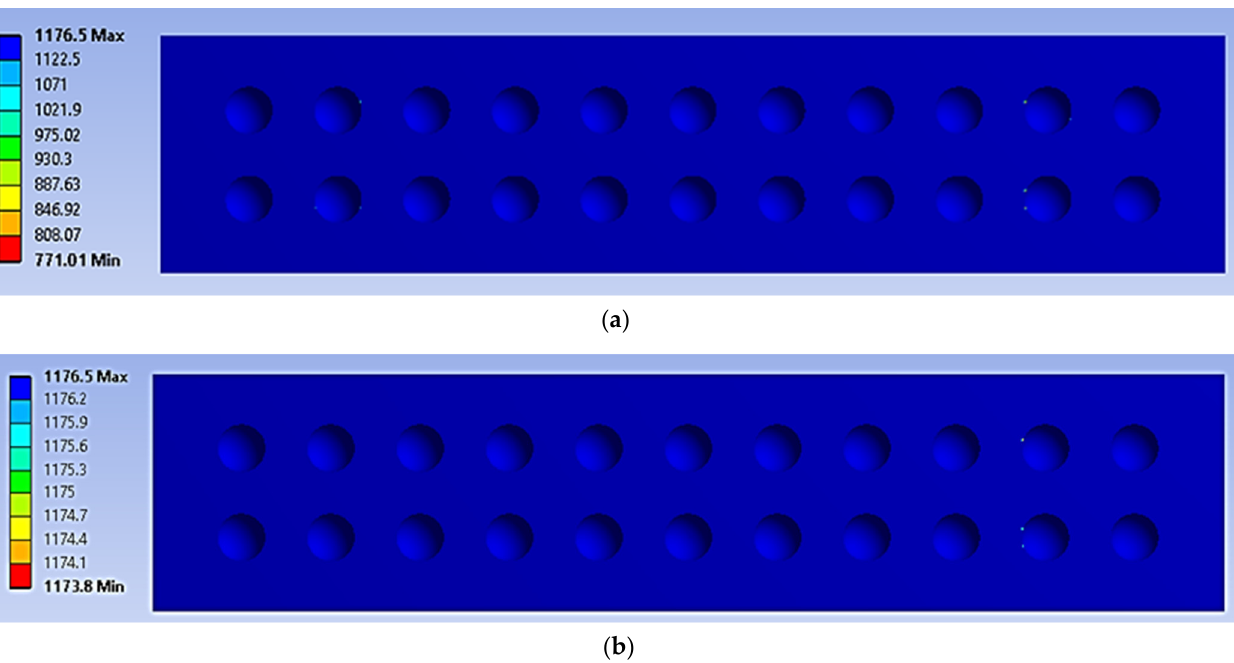
Figure 11. The permanent deformation experienced by a simulated panel under cyclic loading